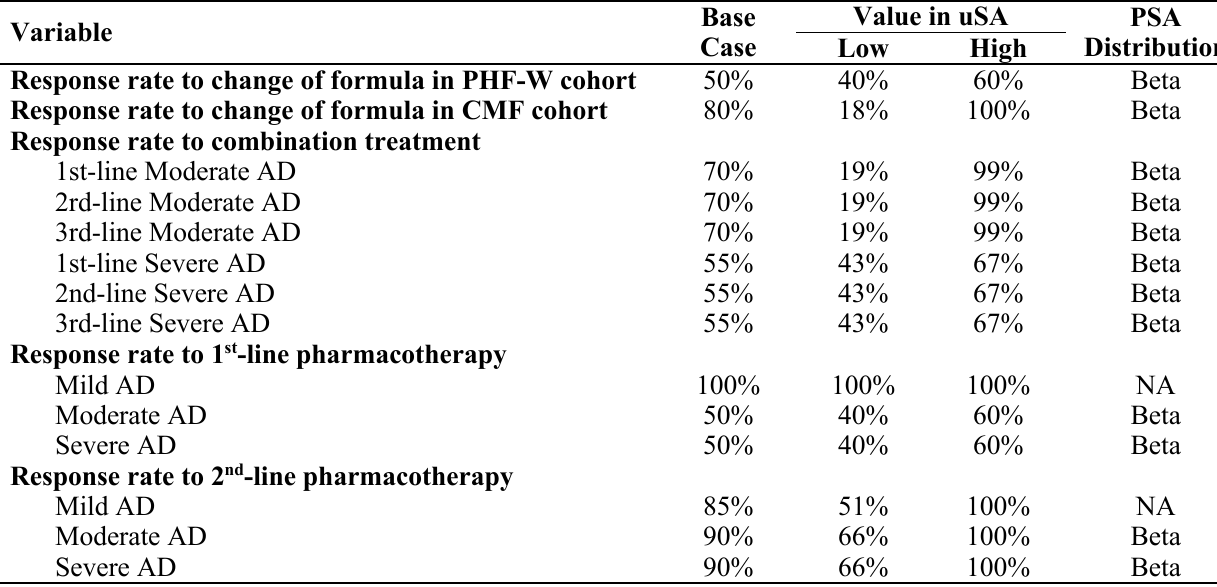
Table 2. Clinical Management and Effectiveness Inputs